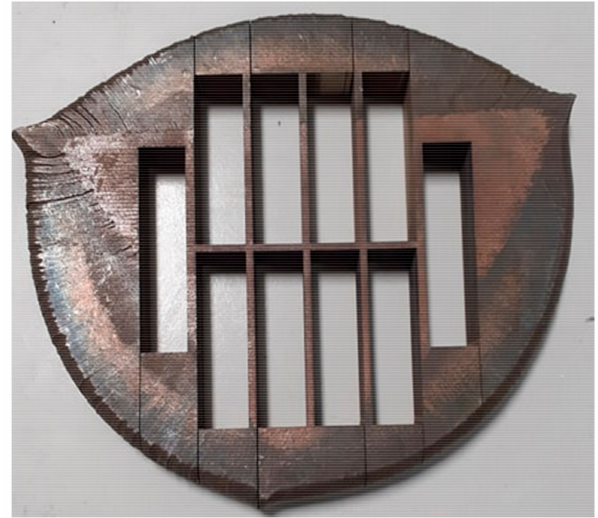
Figure 1. Specimen blank extraction from a pancake